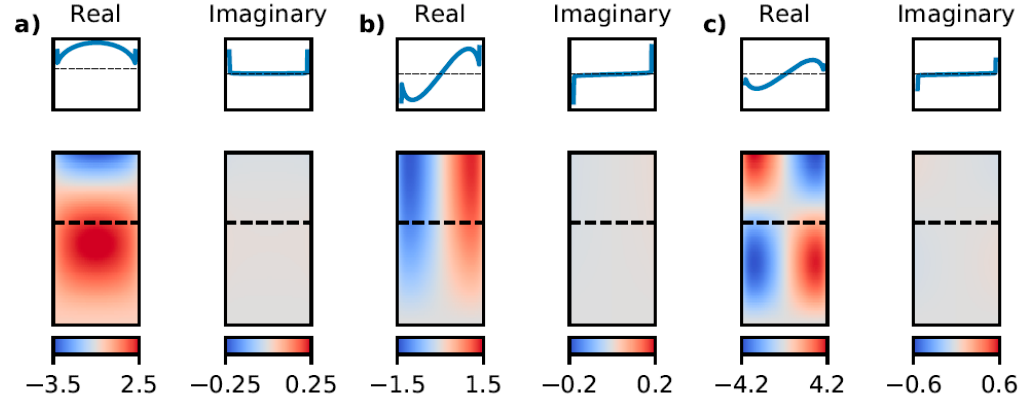
Figure 3. Colormaps of the real and the imaginary part of the complex pressure Δ𝑝 in Pa for to the ( a ) 10-mode, ( b ) the 01-mode and ( c ) the 11-mode. The real part have been scaled by 1/ β and the imaginary part by 10 (cid:2871) /(cid:3493)𝛽 with 𝛽 = 𝜔(cid:3365)𝑏 (cid:2870) /𝜐 . We assume a dynamic kinematic viscosity of 𝜐 = 1.0034 × 10 (cid:2879)(cid:2874) m (cid:2870) /s which corresponds to water. The cantilever is clamped at the bottom of the colormaps and the dashed lines indicate the positions of the cross sections displayed above. The vertical cross section axis limits are the same as the limits for the corresponding